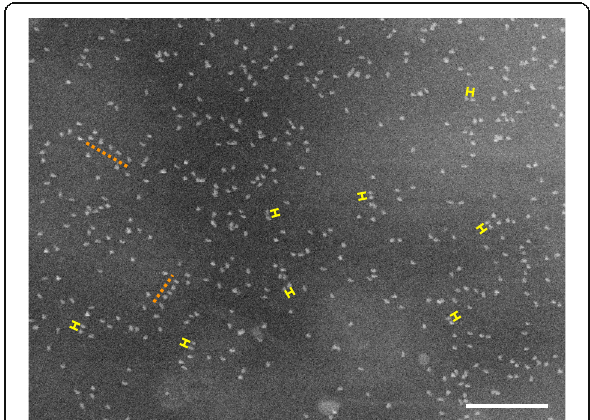
Fig. 6 STEM image (80,000 x) from a cell with a label density of 413 particles/ μ m 2 sufficiently low to allow the recognition of typical spatial distribution features of overexpressed HER2 by eye. Examples of label pairs, presumably, HER2 homodimers, are indicated by yellow, 20 nm long rulers. Two examples of occasionally occurring, linear arrangements of HER2 are indicated by the orange, dotted lines. Scale bar: 200